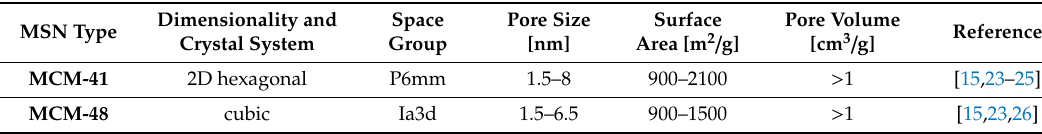
Table 1. The characteristics of the main mesoporous silica nanoparticles (MSNs). MCM, Mobil Crystalline Materials or Mobil Composition of Matter; SBA, Santa Barbara amorphous; FSM, folded sheets of mesoporous materials; TUD, Technical Delft University; HMM, Hiroshima Mesoporous Material; COK, Centrum voor Oppervlaktechemie en Katalyse / Centre for Research Chemistry and Catalysis; FDU, Fudan